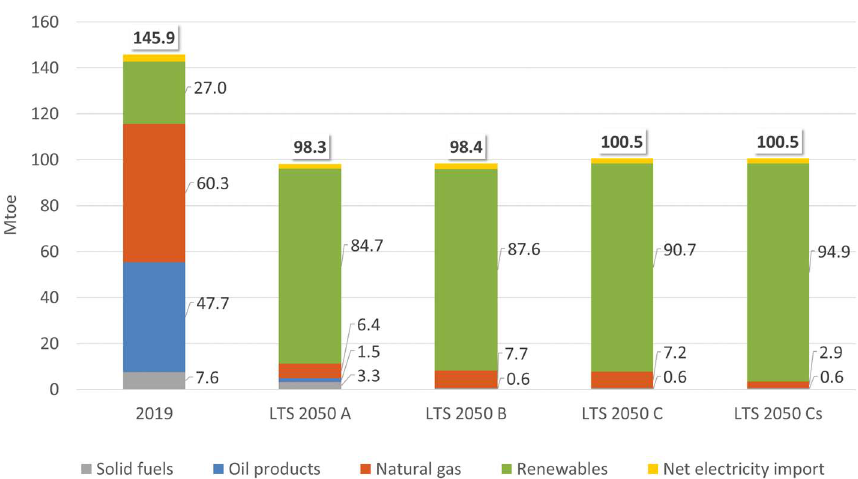
Figure 4. Expected evolution of primary energy consumption (Mtoe): comparison between the current state (2019) and the LTS 2050 decarbonization scenarios.